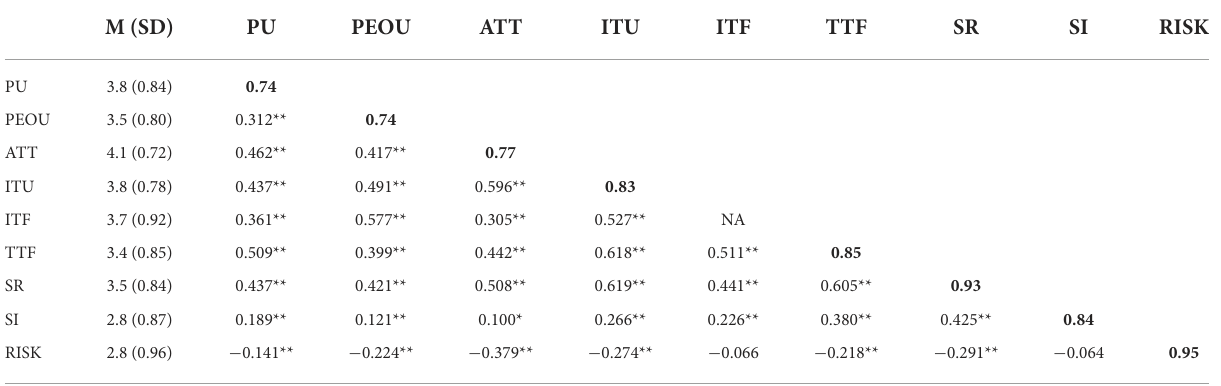
TABLE 3 Inter-construct correlations and discriminant validity.